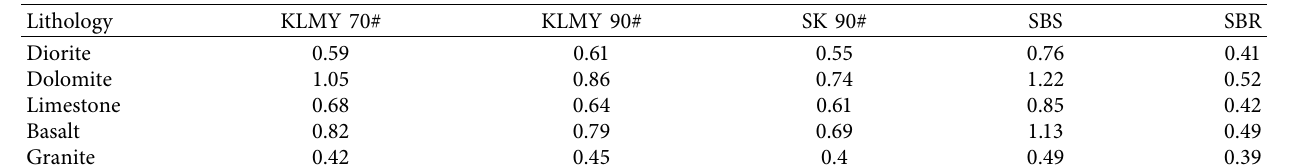
Figure 5: Spindle coated with asphalt components. (a) Aromatics. (b) Colloid. (c) Saturation. Table 6: Bond strength test results.